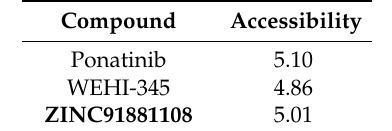
Table 9. Prediction of synthetic accessibility of ponatinib, WEHI-345 and the selected compound ZINC91881108